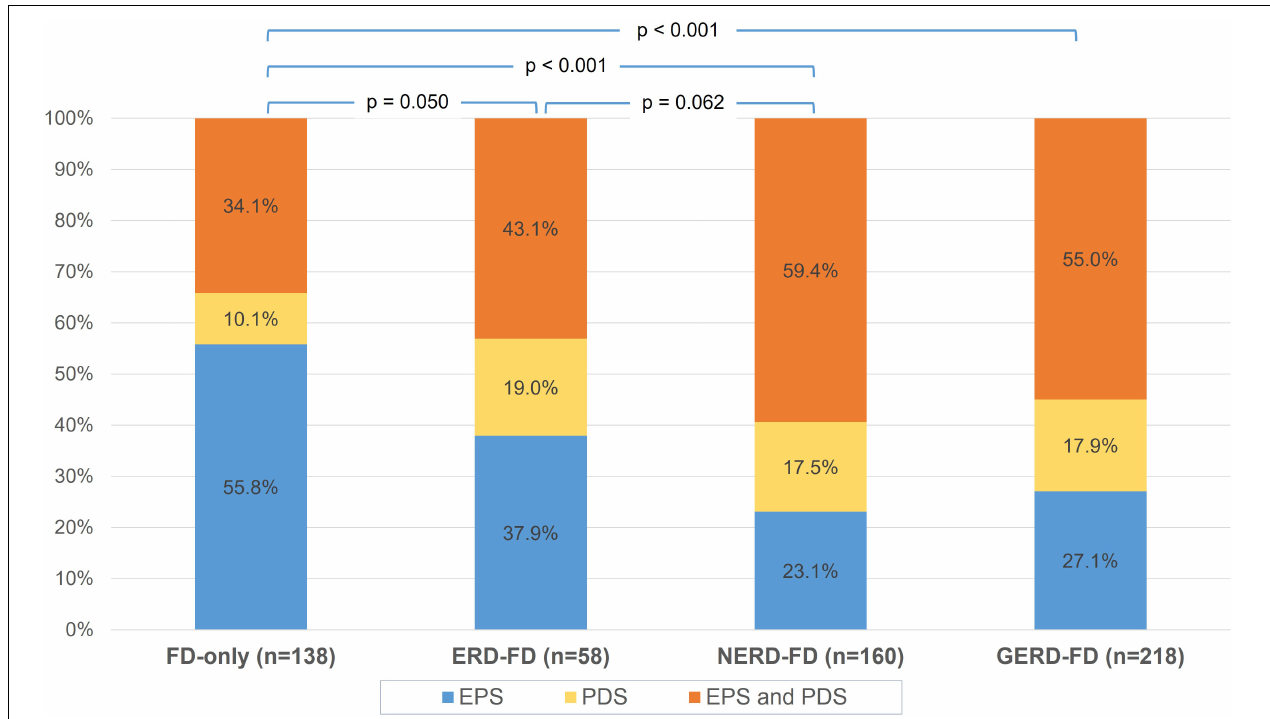
FIGURE 3 | The distribution of epigastric pain syndrome (EPS) and postprandial distress syndrome (PDS) across FD-only and GERD-FD overlap groups. FD, functional dyspepsia; GERD, gastroesophageal reflux disease; ERD, erosive reflux disease; NERD, non-erosive reflux